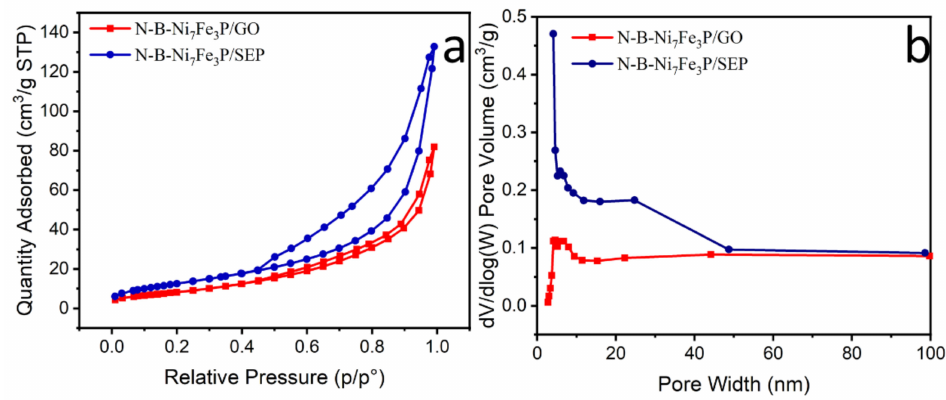
Figure 6. N 2 adsorption–desorption curves ( a ), and pore distribution curve ( b ) of N-B-Ni 7 Fe 3 P/SEP and N-B-Ni 7 Fe 3